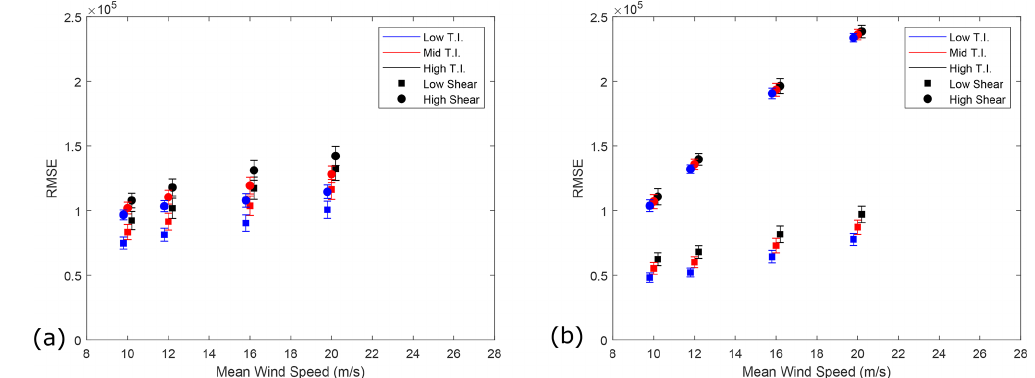
Figure 7. (a) RMSE between reaction forces from the analytical and DTRB FE model in the horizontal plane . The mean and standard deviations within each CPLS are plotted, staggered about mean wind speed for clarity. (b) RMSE reaction force results between the analytical and DTRB FE model in the vertical plane . The mean and standard deviations within each CPLS are plotted, staggered about mean wind speed for